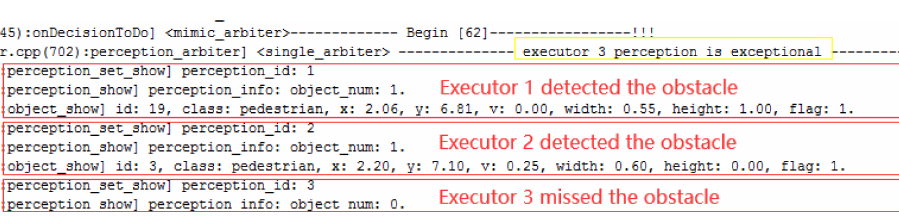
Figure 6. The arbitration process of DHR under functional failure (one